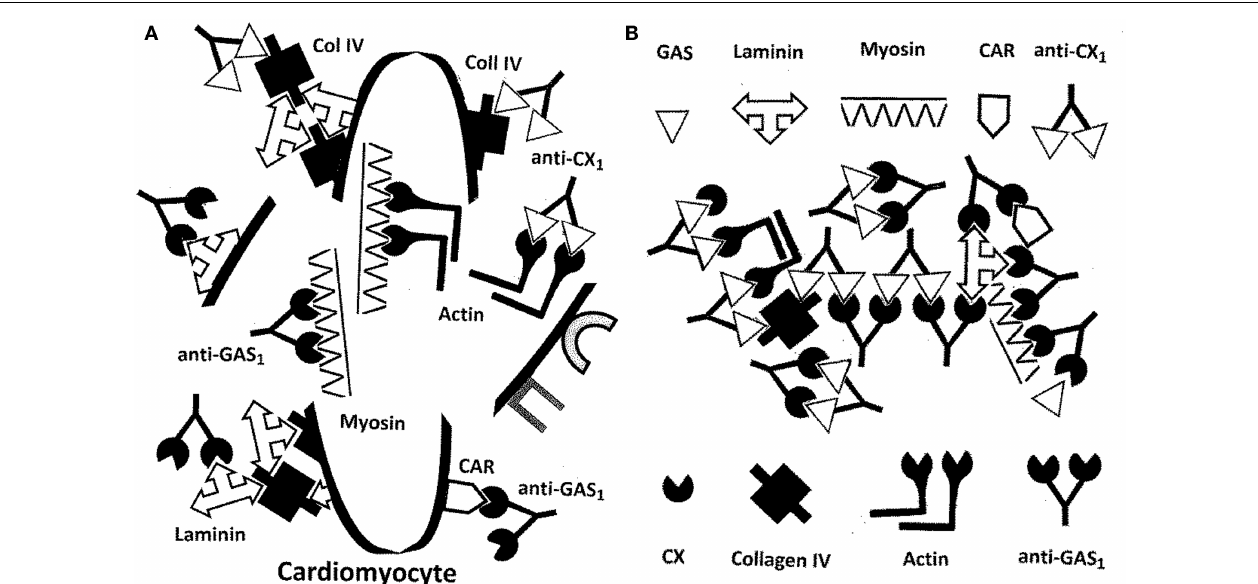
(CX) mimic collagen IV and actin as well as the beta 1 adrenergic receptor (B1AR – not shown). In consequence, antibodies against CX also recognize collagen IV and actin (and possibly B1AR, not yet demonstrated), while antibodies against GAS M protein also recognize laminin, myosin, and possibly CAR, not yet demonstrated. It also follows that antibodies against GAS are complementary to antibodies against CX, so that anti-CX mimics GAS, laminin, myosin, and CAR; and antibodies against CX are complementary to antibodies against GAS, so that anti-GAS mimics CX epitopes, collagen IV, actin, and possible B1AR.The antigenic complementarity of GAS for CX will therefore lead their antibodies to precipitate each other and to form circulating immune complexes involving GAS and CX proteins as well as the entire range of host protein targets.The immune system will be unable to distinguish “self” from “non-self” leading to abrogation of tolerance and the induction of autoimmune disease. Note once again that the same consequences would occur forT-cell mediated responses as are illustrated here for